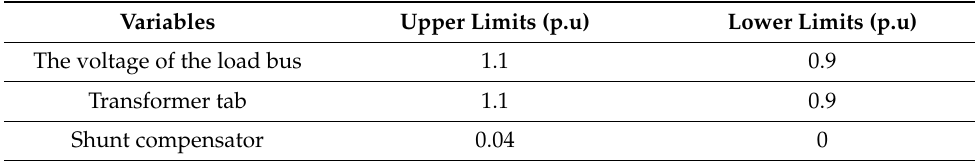
Table 2. The control variable boundaries of the IEEE 30 bus system, reproduced with permission from [38], Institution of Engineering and Technology (IET), 2007.